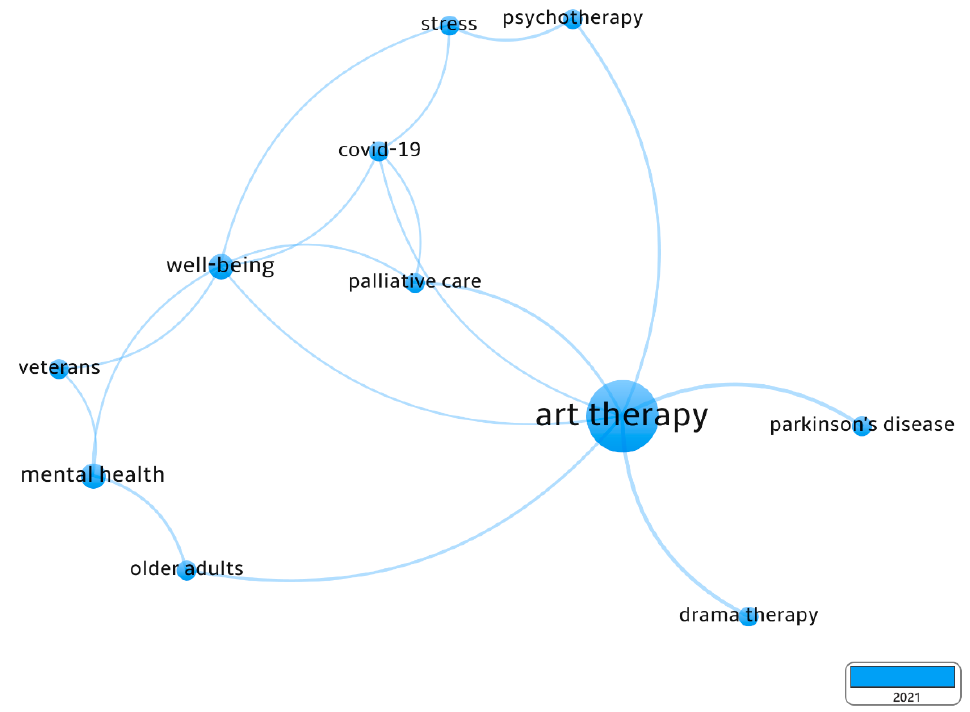
Figure 6. Latest research keywords of AT-aided health and well-being in 2021 via VOSviewer (devised by the authors).